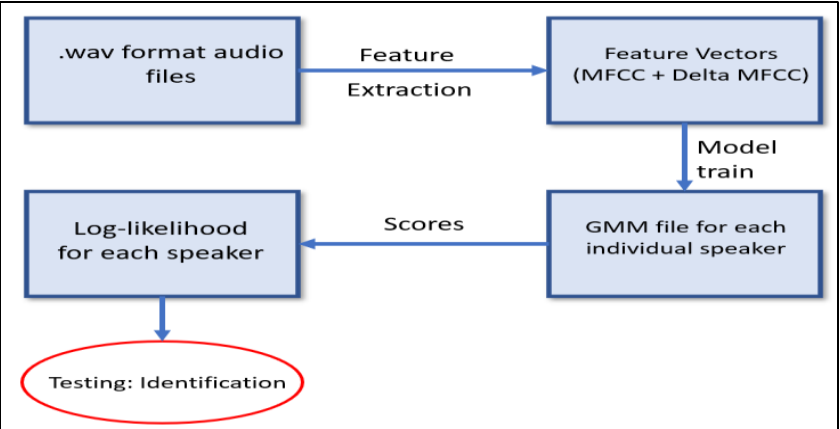
Figure 5. State transition diagram [28].